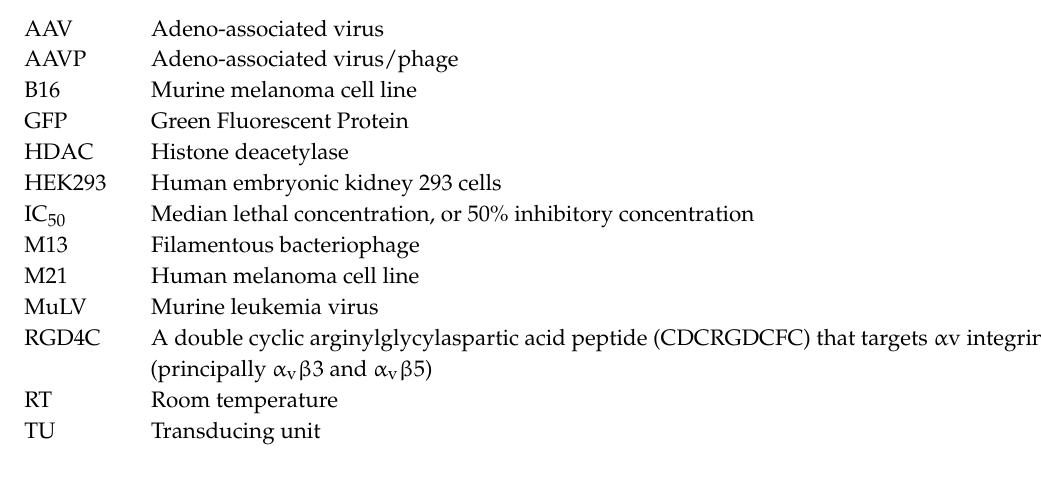
Figure S1: Phase contrast images of M21 cells taken at day 6 post vector transduction with targeted AAVP or non-targeted vector. Untreated cells are shown as